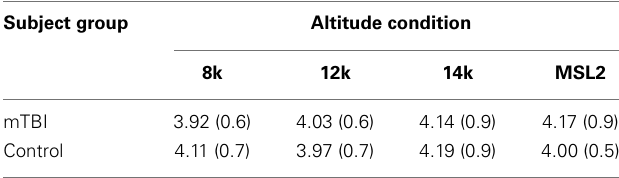
Table 4 | Mean (SD) duration in minutes between starting the exposure to the altitude condition and starting BrainCheckers